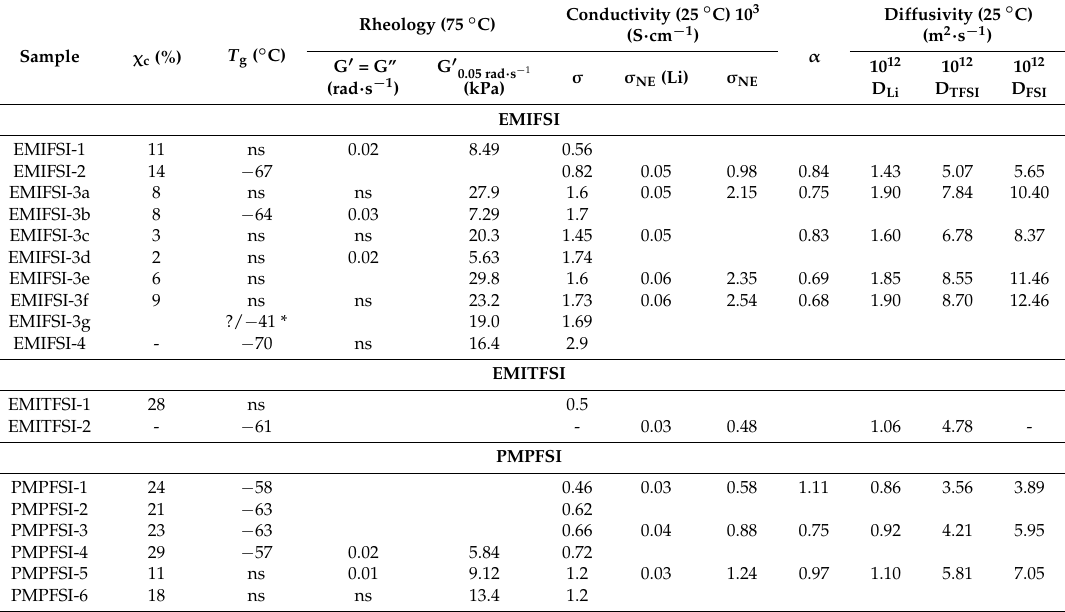
Table 2. Physicochemical characterization of the electrolytes.